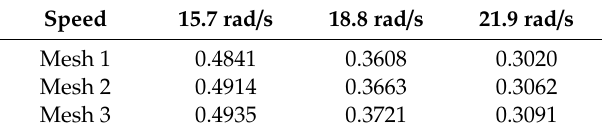
Table 1. Oil volume fraction results under di ff erent mesh resolutions and